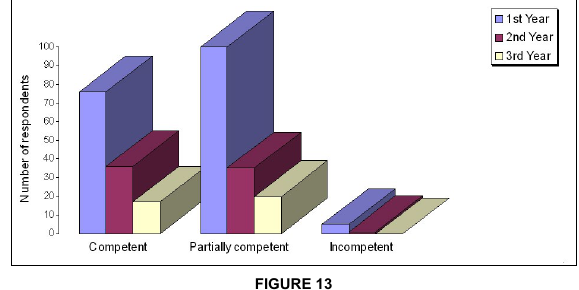
FIGURE 13 Levels of competency using the